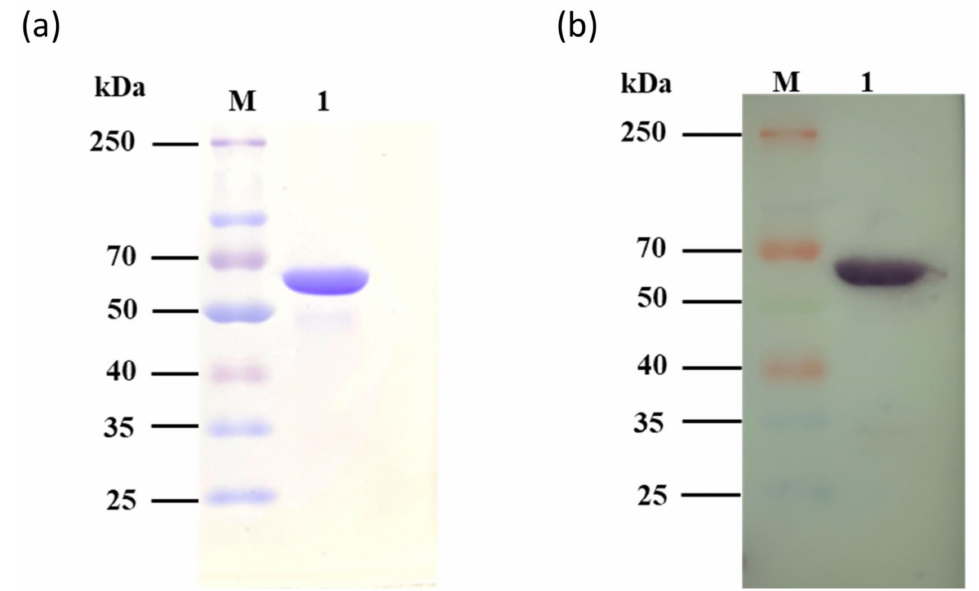
Figure 4. Investigation of the intracellular HL11Amy produced recombinantly in E. coli BL21(DE3). ( a ) Purified HL11Amy on SDS-PAGE analysis. ( b ) Purified HL11Amy on Western blot analysis. Lane M represents pre-stained protein marker (Thermo Scientific). Lane 1 represents purified HL11Amy